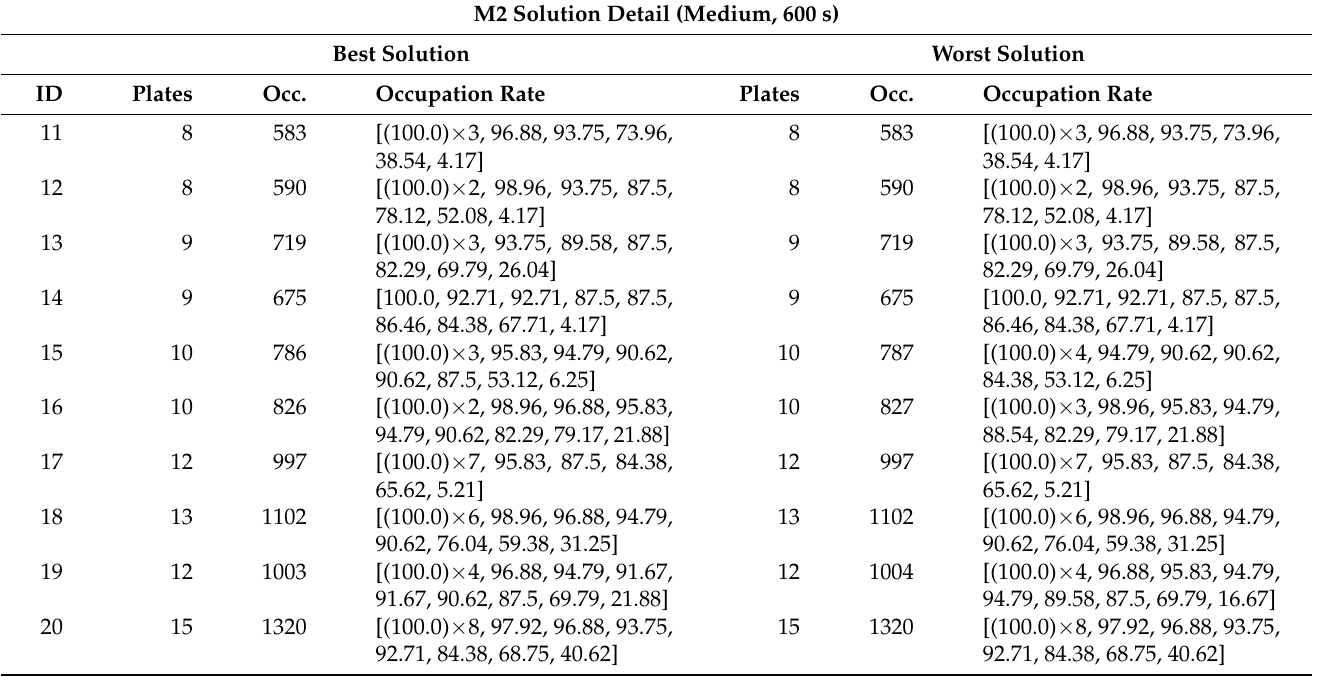
Table A15. M2 best and worst solutions obtained for small and medium files, limited to 600s.